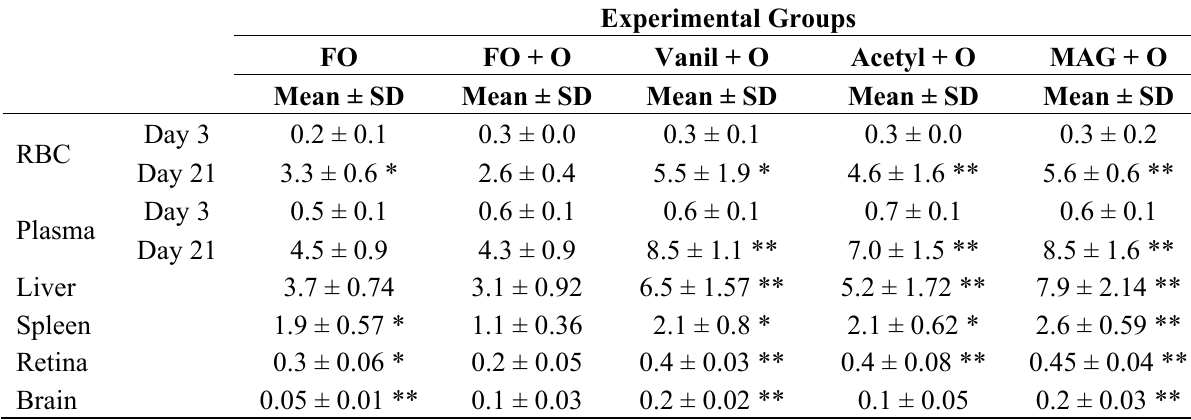
Table 3. Level of EPA (g/100 g fatty acids) in RBC, plasma, liver, spleen, retina and brain in